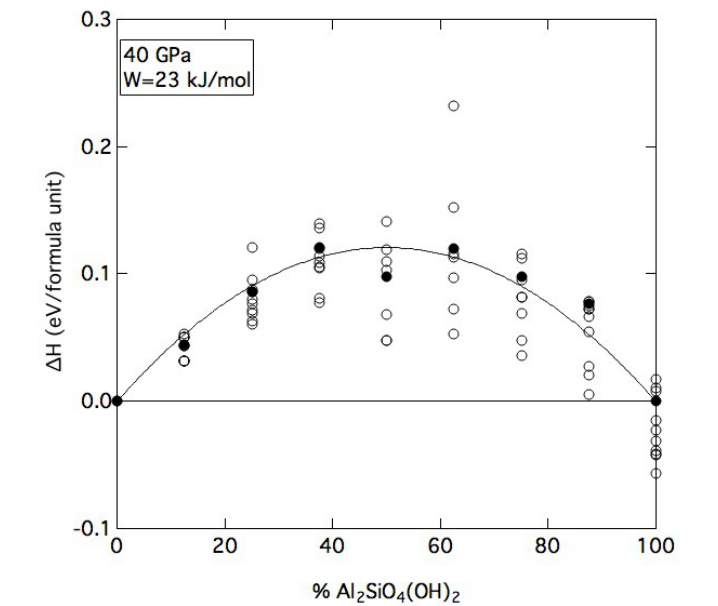
Figure 3. Excess enthalpy of solution for each configuration and composition at 40 GPa (open circles) as a function of aluminum content. The excess enthalpy expectation value (closed circles) at each composition can be well described by a regular solution with an interaction parameter of 23